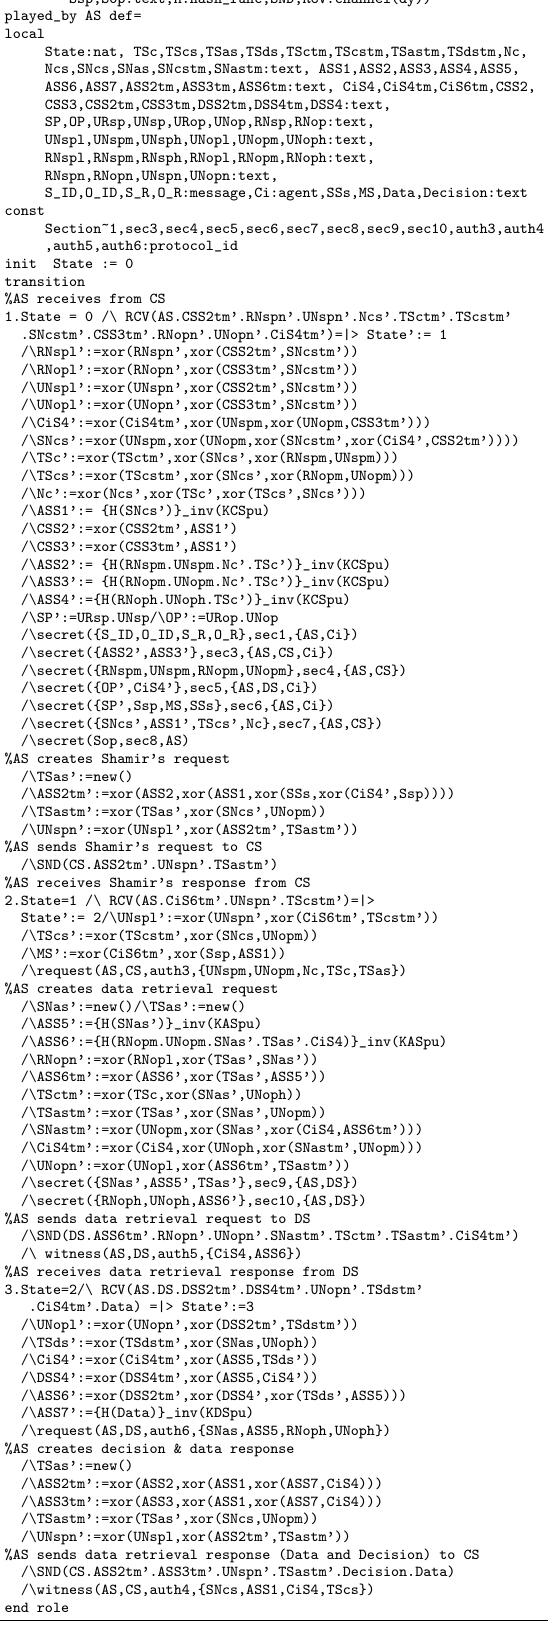
Figure A3. AS role of PAX in HLPSL. Figure A4. DS role of PAX in HLPSL.